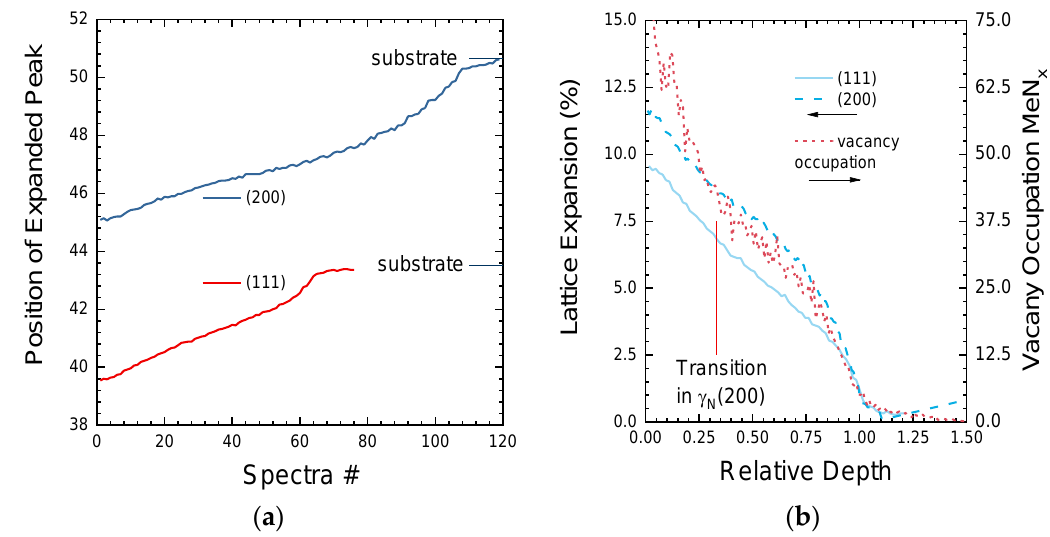
Figure 7. ( a ) Peak position for expanded austenite as a function of depth using the differential spectra from Figure 5b; ( b ) comparison of lattice expansion and nitrogen content as a function of depth normalized for the different sputter rates.